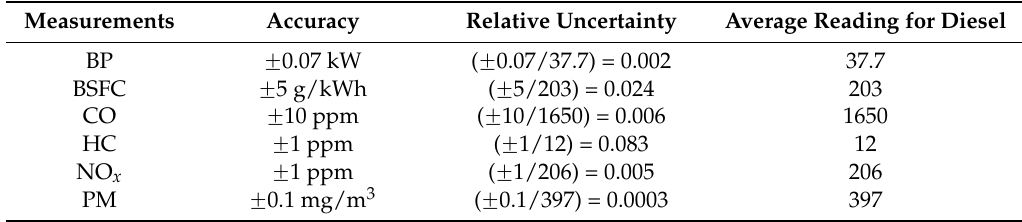
Table 7. Relative uncertainty for parameters brake power (BP), brake-specific fuel consumption (BSFC), carbon monoxide (CO), hydrocarbons (HC), nitrogen oxides (NO x ) and particulate matter (PM)